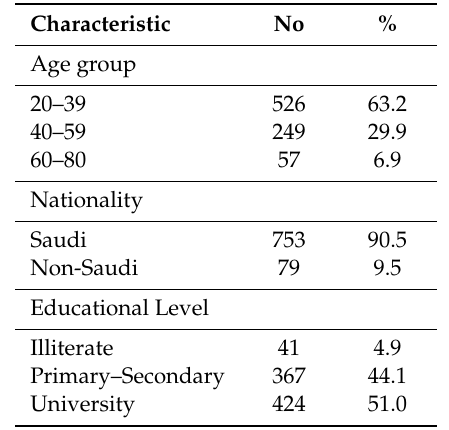
Table 1. Sociodemographic characteristic of the study sample of husbands ( n =